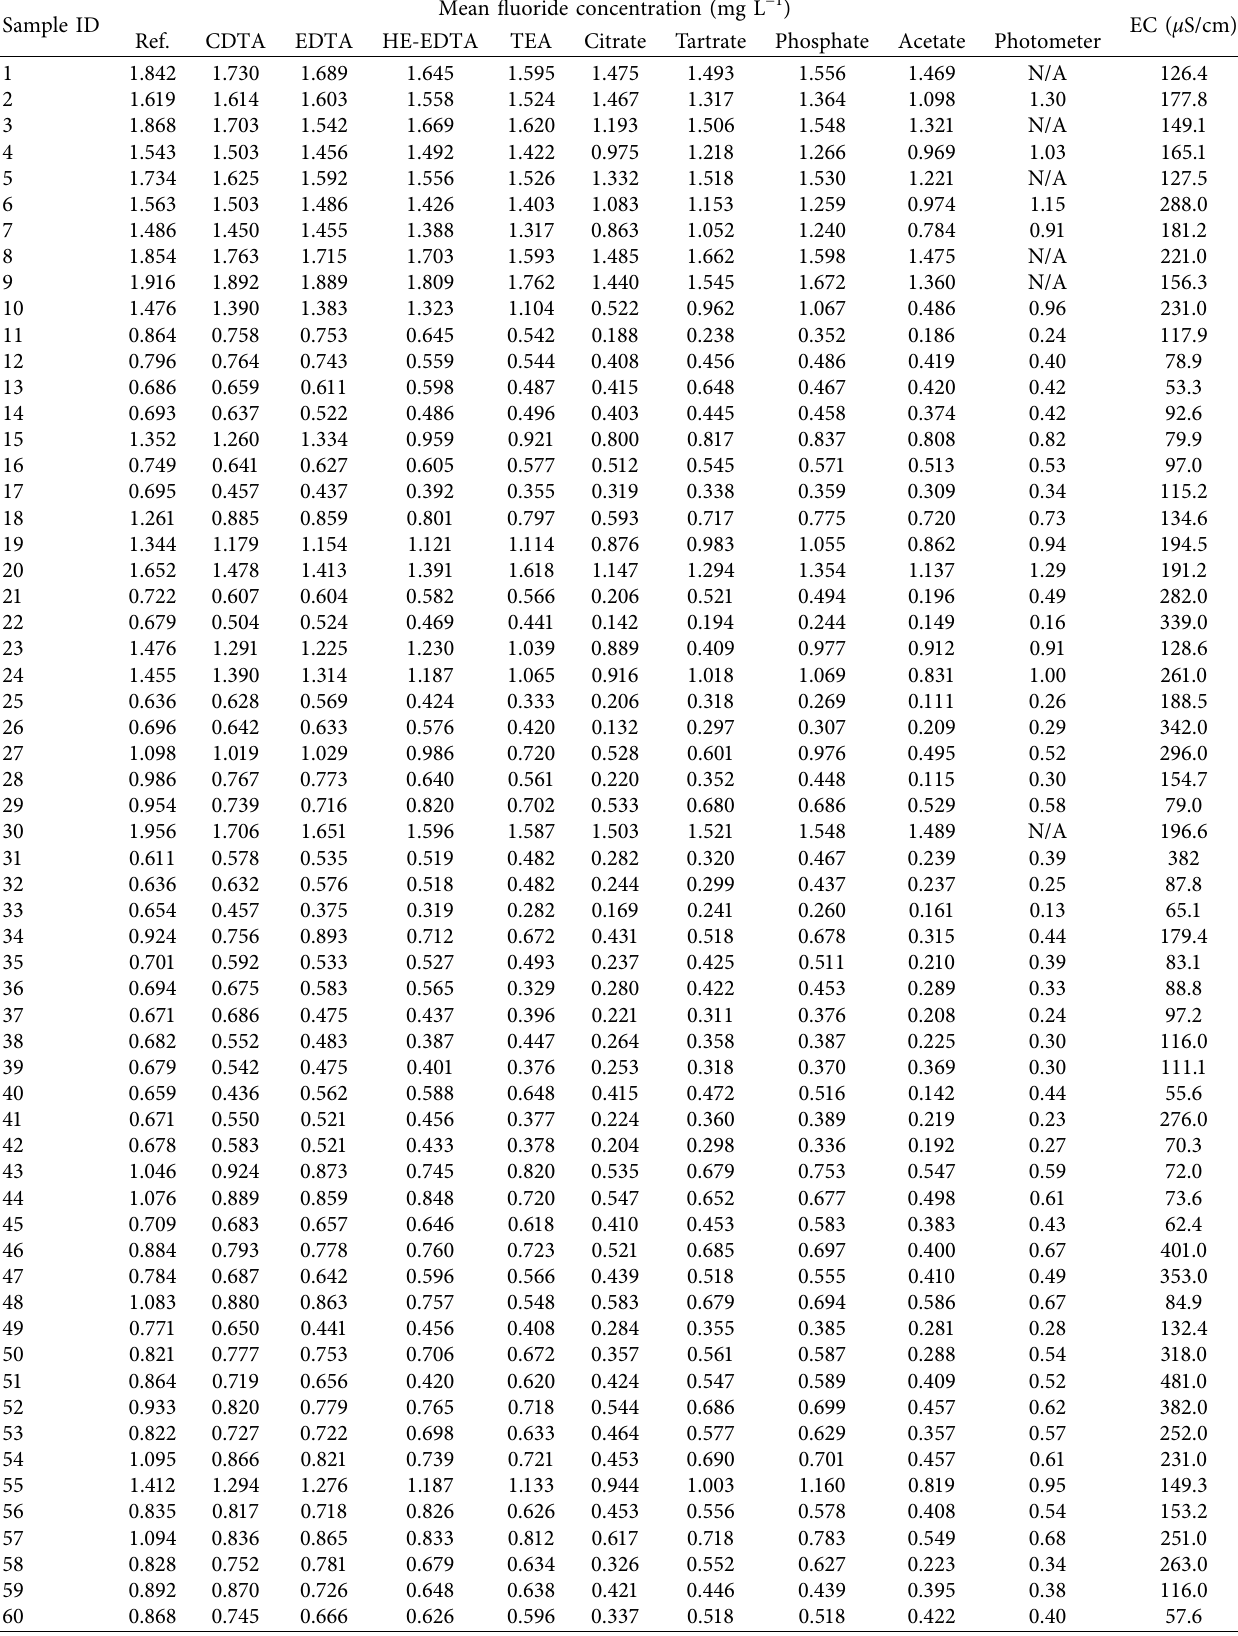
Table 1: Fluoride content of 60 water samples measured by F-ISE with different masking agents. Sample